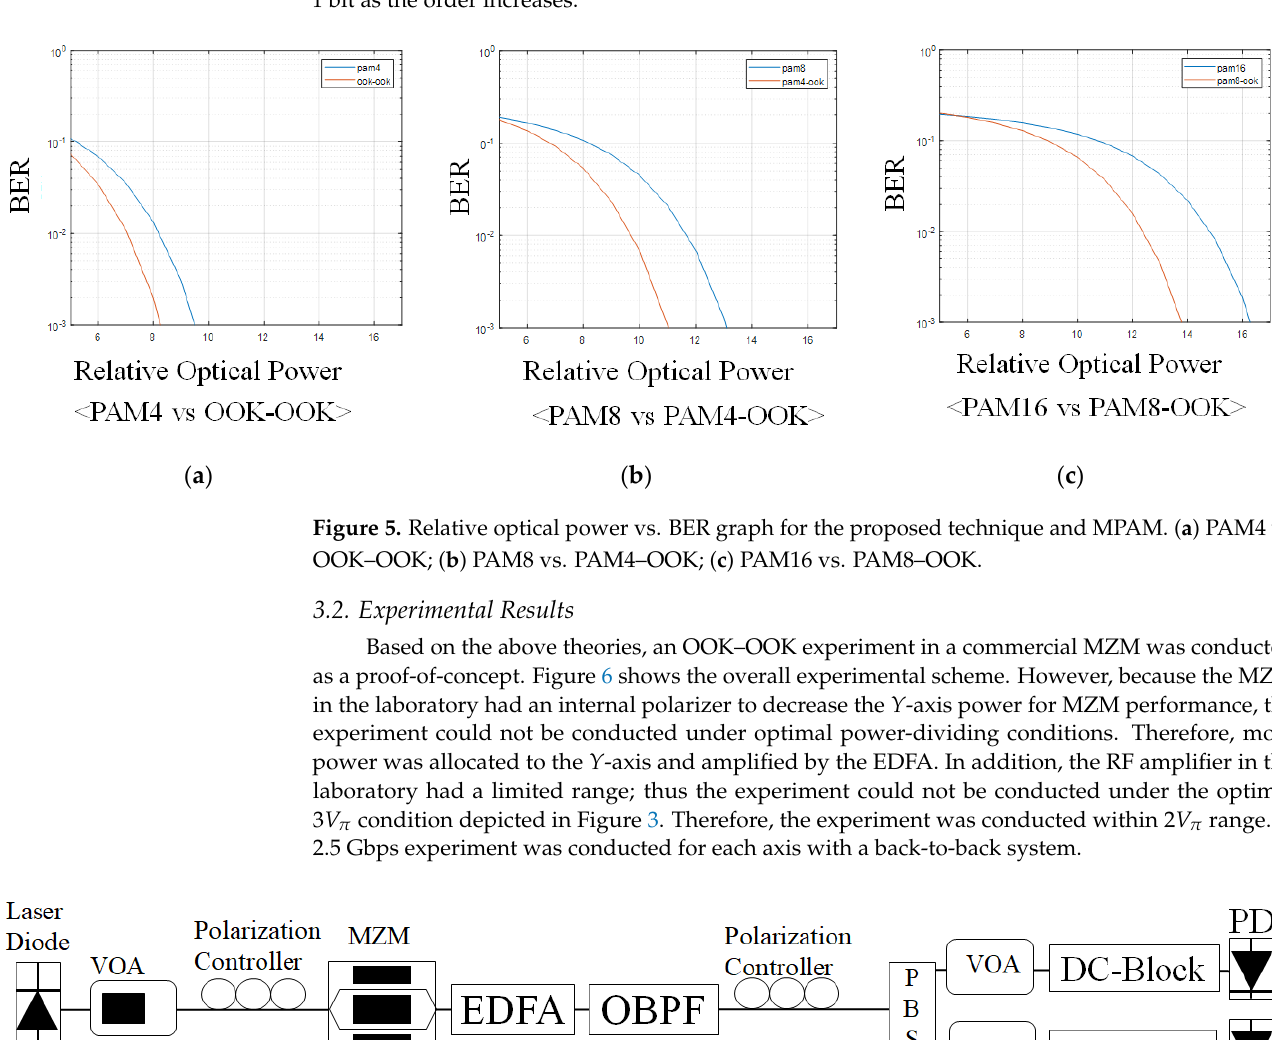
( b ) Figure 7. 5 Gbps (2.5 GHz) OOK − OOK eye diagram: ( a ) X − axis; ( b ) Y − axis. The received optical power vs. BER graph for theoretical OOK – OOK and experimen- tally measured OOK – OOK is depicted in Figure 8a. In this graph, the received optical power is the total received power of each axis. The theoretical value is the simulated BER when the voltage swing is in a 2V 𝜋 range for the given noise power. It can be seen that the measured OOK – OOK performance is less than the theoretical value. This is because, as mentioned above, the experiment could not be conducted under optimal conditions owing to the internal polarization of the MZM in the laboratory and the limitations of the RF amplifier. The measured voltage-intensity transfer curve for each axis is shown in Fig- ure 8b. It can be observed that the Y -axis transfer curve is not an ideal transfer curve. This limits the performance of the proposed technique. However, these were all experimental errors. If the experiment is performed under optimal conditions, modulation with a higher spectral efficiency can be conducted with a single MZM.